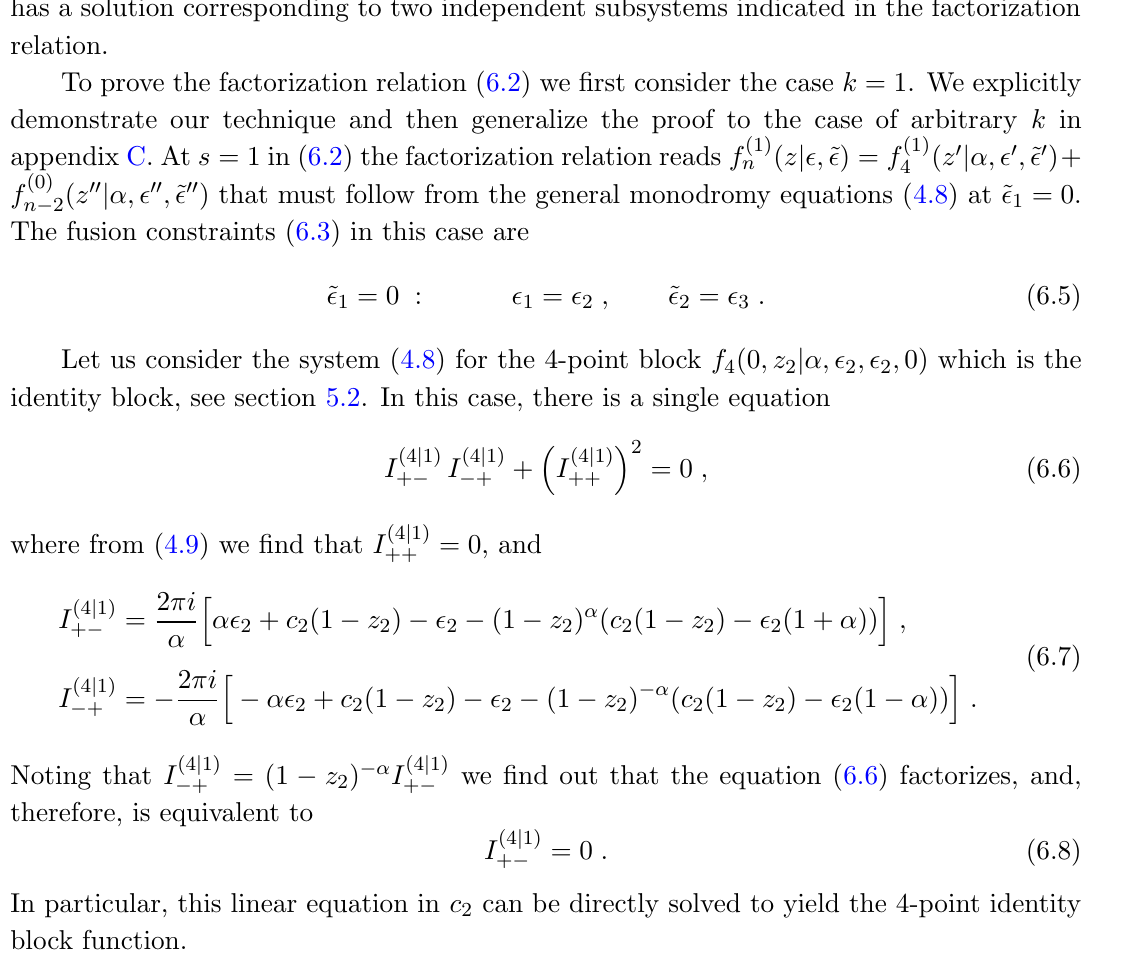
Figure 8 . Factorized 7-point block. Figure 11 . The factorization relation for the identity block from (cid:12)gure